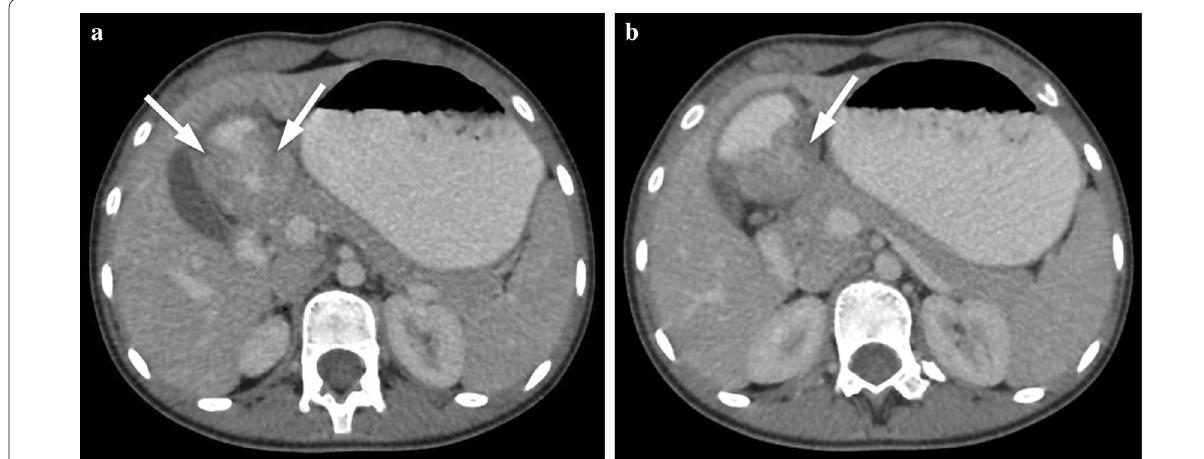
Fig. 10 a, b A 12-year-old girl with gastric adenocarcinoma (signet ring cell carcinoma). She had complaints of abdominal pain, vomiting and weight loss that started 3 months ago. a, b Axial contrast-enhanced CT images demonstrate hypodense tumor at the antrum of the stomach (arrows) observed as pathological wall thickening